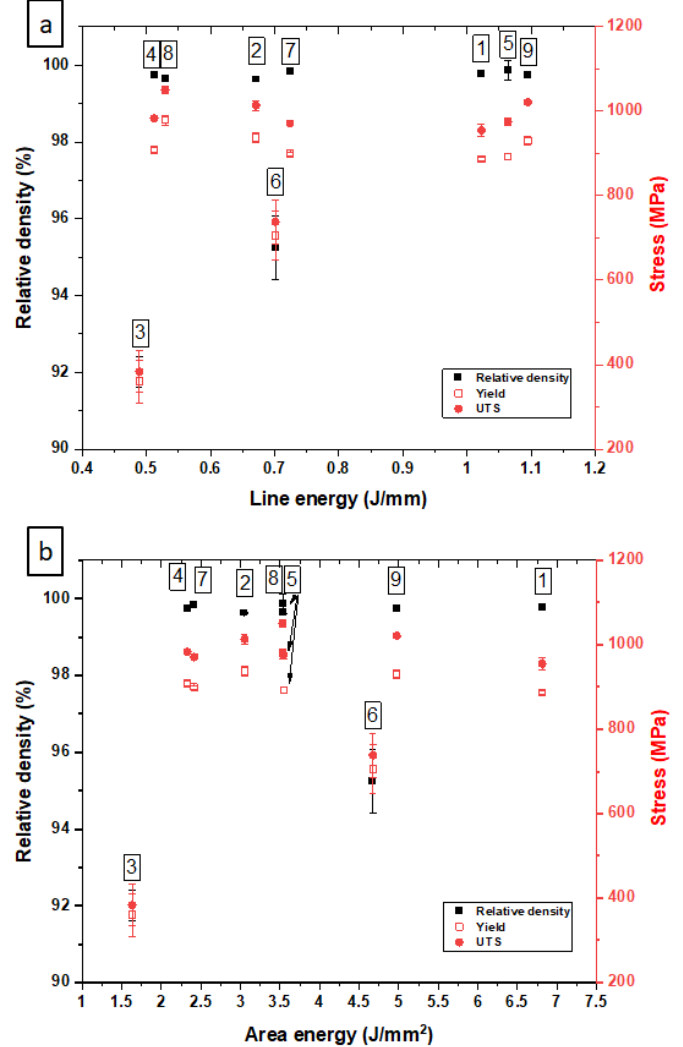
Figure 9. Effect of the line ( a ) and area ( b ) energy density on density, yield, and ultimate tensile strength.